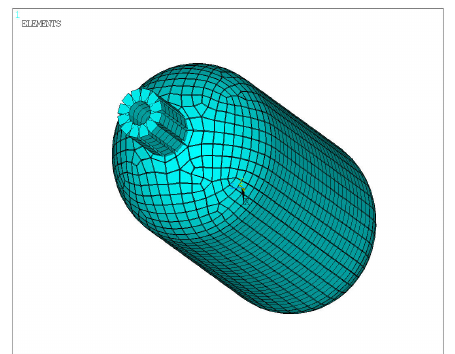
Figure 3. Fiber layer grid diagram.